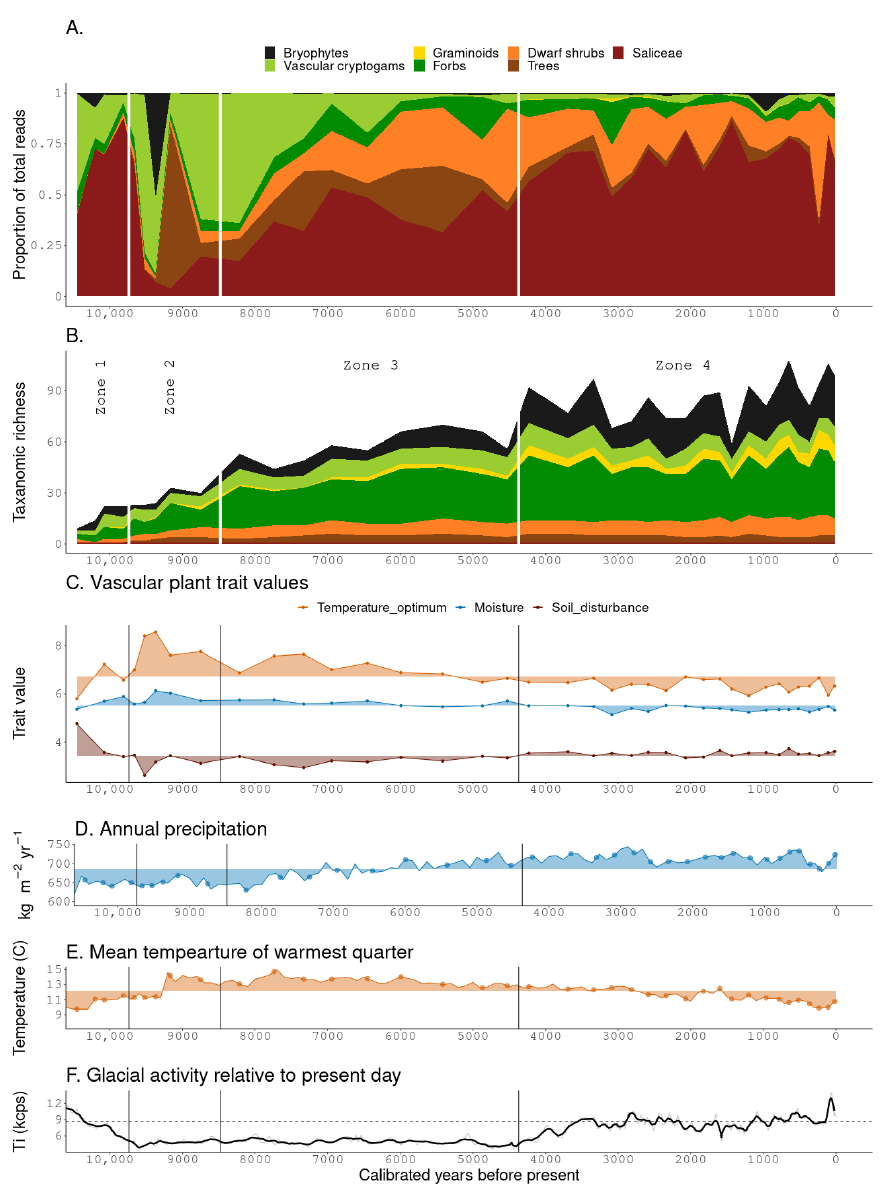
Figure 2. An overview of sed aDNA results, climate reconstructions, and glacial activity. CONISS zone boundaries are demarcated with vertical bars at 9.7, 8.4, and 4.3 ka. ( A ) Proportion of total identified reads by plant functional group. ( B ) Stacked taxonomic richness for each functional group. ( C ) Average weighted vascular plant trait values are based on plants identified in the sedaDNA combined with plant trait values reported in [21]. Note that temperature optimum index values are inverted from those reported in [21]. High values indicate high temperature optimum, high moisture requirement and high dependents of soil disturbance. ( D ) Annual precipitation data (bio12) from [24]. Points represent the age of samples taken from the core. ( E ) Mean temperature of the warmest quarter (bio10) from [24]. Points represent the age of samples taken from the core. ( F ) Glacial activity relative to the present day (dashed horizontal line) adapted from